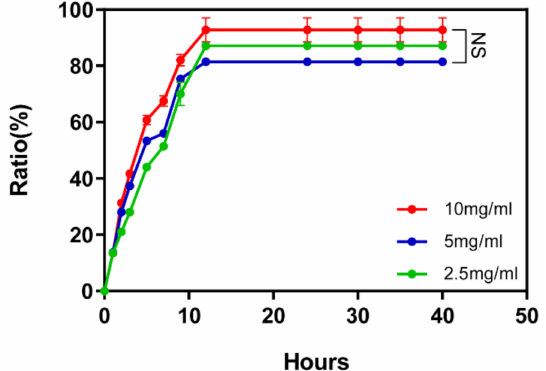
Figure 9. Controlled release of OVA in different concentrations of self-assembling peptide hydrogel DRF3 (The results were repeated three times, shown as mean ± SEM; NS means no significant differences p >